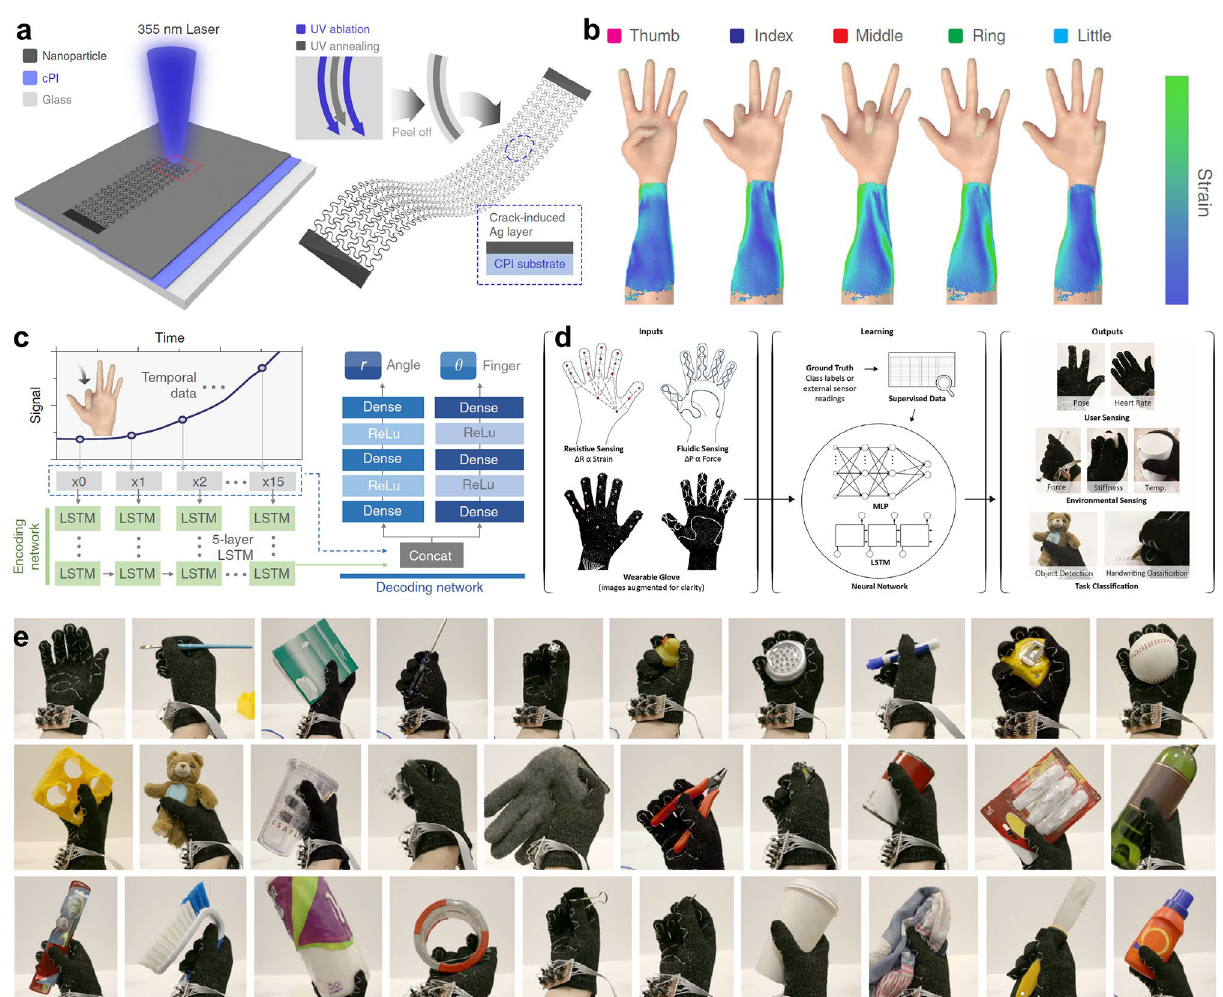
Fig. 29 RNN for the classification task. a Schematic depicting the patterning and crack fabrication by laser fabrication. b Depiction of skin deformations for different finger bending motions. c Neural network composed of an encoding network and a decoding network. LSTM layers are used in encoding network to analyze temporal sensor patterns to generate latent vectors. Two independent dense layers map created latent vectors to the metric space expressing hand motions. Dropout is used as the regularization technique to prevent the network to be overfitted to a single use case. Reproduced with permission [344]. Copyright (2020), Springer Nature. d Resistive sensing and fluidic sensing are combined to provide signals for strain and contact force information, respectively. These signals are fed into a pretrained neural network architecture for infer- ence, which is trained from captured data labeled with ground-truth knowledge. Depending on the neural network, the output of the network pro- vides inference for a wide variety of downstream tasks. Electrode points which are usually not visible have been colored and enlarged in the left- hand images for clarity. e Object classification dataset, with associated grasps. Reproduced with permission [34]. Copyright (2020),